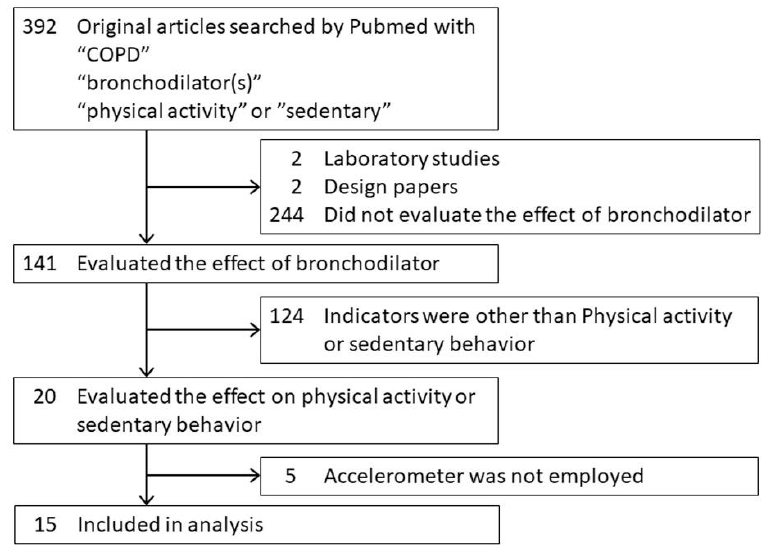
Figure 3. PRISMA flow diagram.